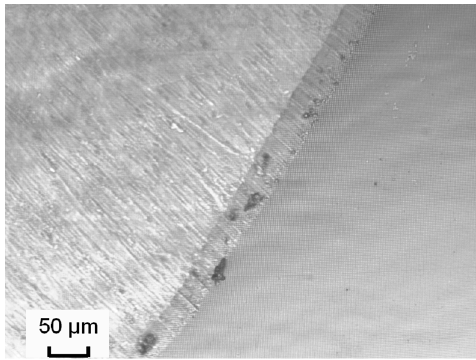
Figure 3. Optical microscope image at 300 × magnification of a boundary between 2A imprinted and mechanically deformed areas of the microstructured PETMP-TTT film.